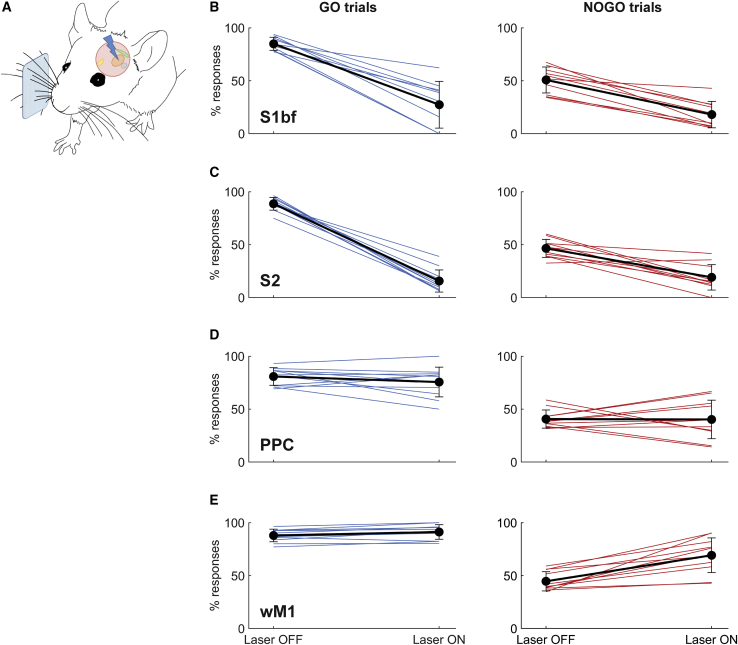
Tracking the Participation of Different Cortical Regions with Optogenetic Activity Suppression(A) Diagram of experimental setup. Cortical areas were illuminated with a blue laser during trial performance.(B) Effects of S1bf suppression on performance (lick response rates) on GO (left) and NOGO trials (right).(C) Effects of S2 suppression.(D) Effects of PPC suppression.(E) Effects of wM1 suppression. Black lines: means across sessions; error bars: SD; colored lines: individual sessions.See also Figure S2.